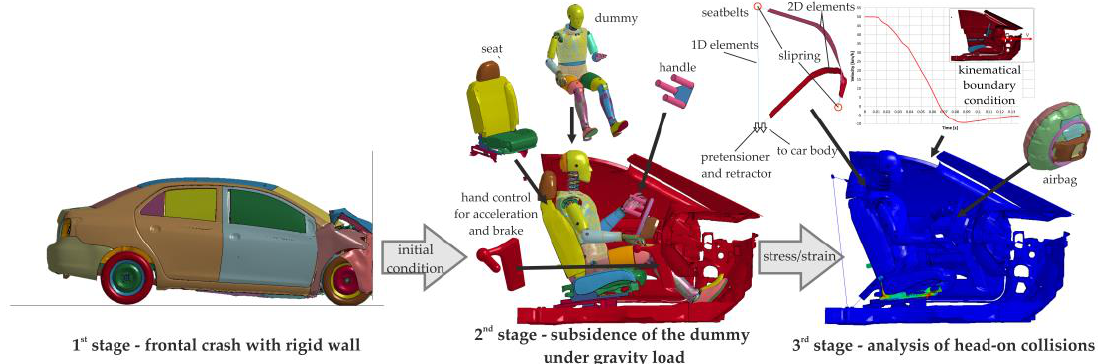
Figure 1. Numerical research strategy [28].